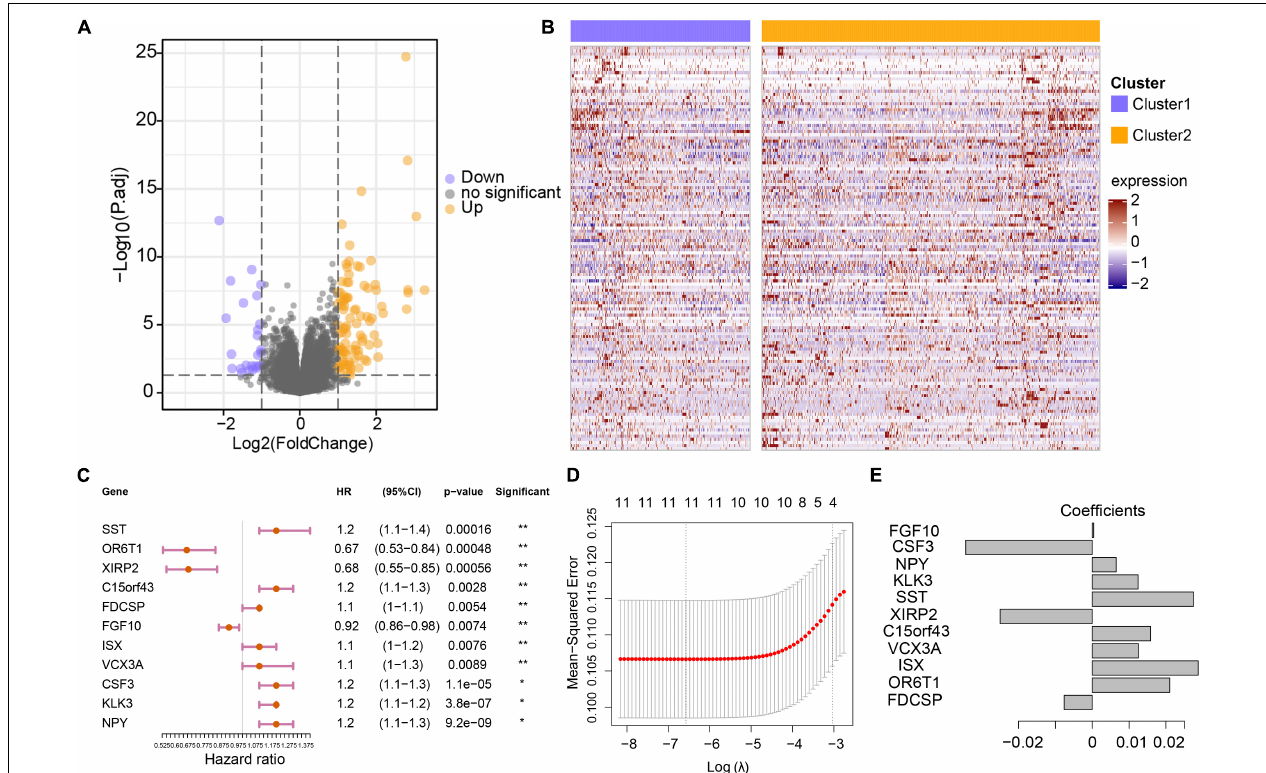
FIGURE 3 | Construction of the genomic variation-related prognostic risk model. (A) The volcano plot indicates the association between log2 fold change and P -value in DEGs between cluster 1 and cluster 2. (B) The abundance of differentially expressed genes between cluster 1 and cluster 2. The row names of the heatmaps indicate the 130 DEGs, while the columns of the heatmaps indicate the samples. (C) Univariate analyses of 11 significant genes with overall survival (* p < 0.05 and ** p < 0.01). (D) The partial likelihood deviation ( λ ) under each logarithm in the LASSO Cox regression model. (E) The coefficients of each independent variable in the LASSO Cox regression